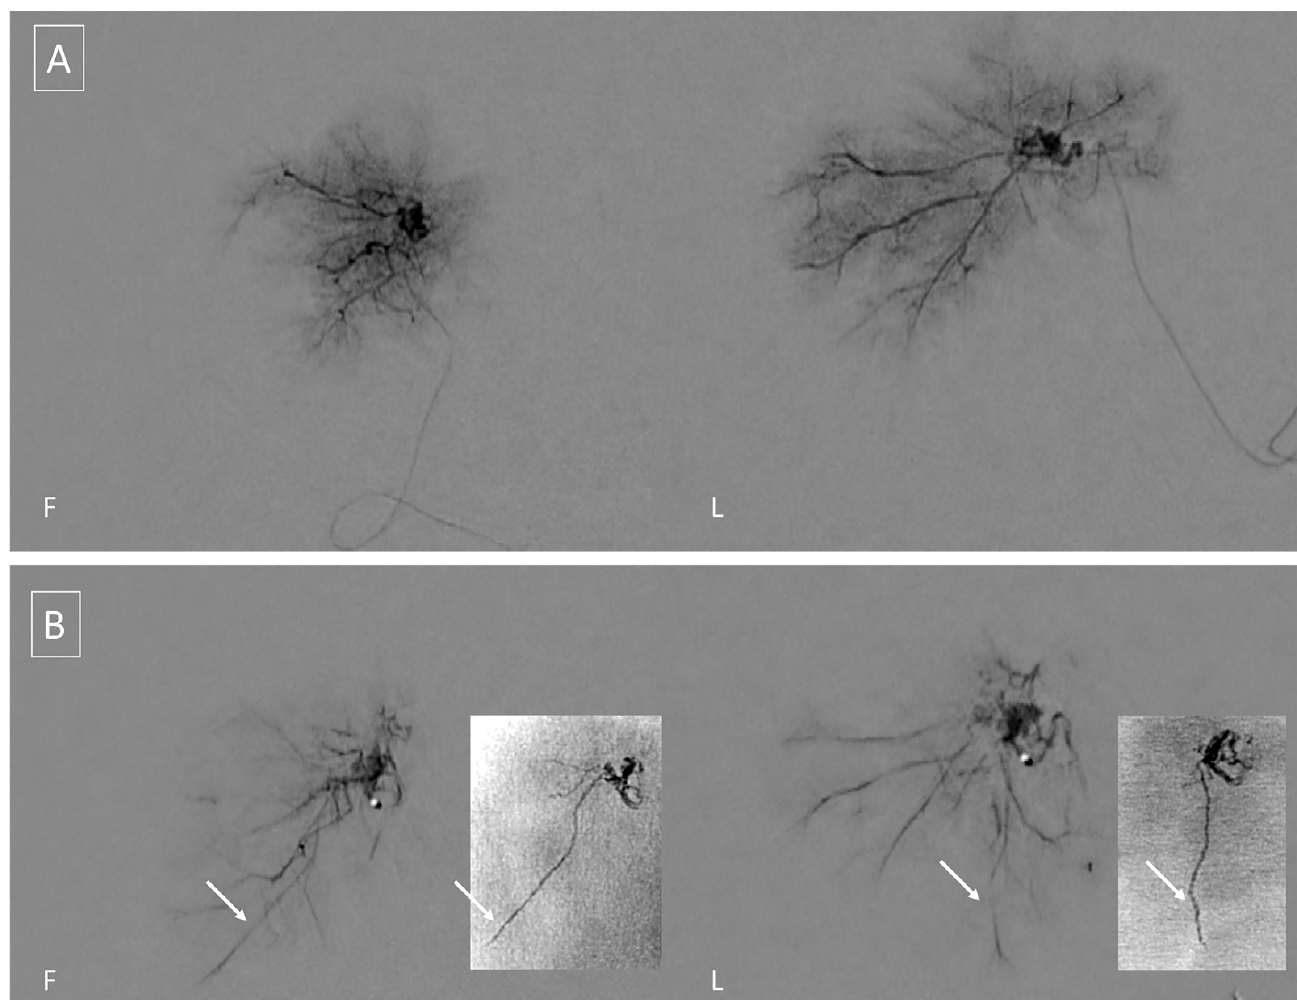
Figure 2. ( A ) Tumoral blush during superselective free-flow contrast injection in Frontal (F) and Lateral (L) views. ( B ) Forced injection of contrast media is performed to test for the presence of dangerous anastomosis. By comparison, with injection A, note the appearance of an additional vessel which corresponds to the course of the posterolateral choroidal artery. Unsubtracted images (small quadrants) of the final glue cast show penetration in the vascular bed of the tumor, and in the right posterolateral choroidal artery; penetration in the latter should be anticipated, even in the absence of enlarged posterior choroidal feeders, and should be carefully monitored to avoid potential complications.